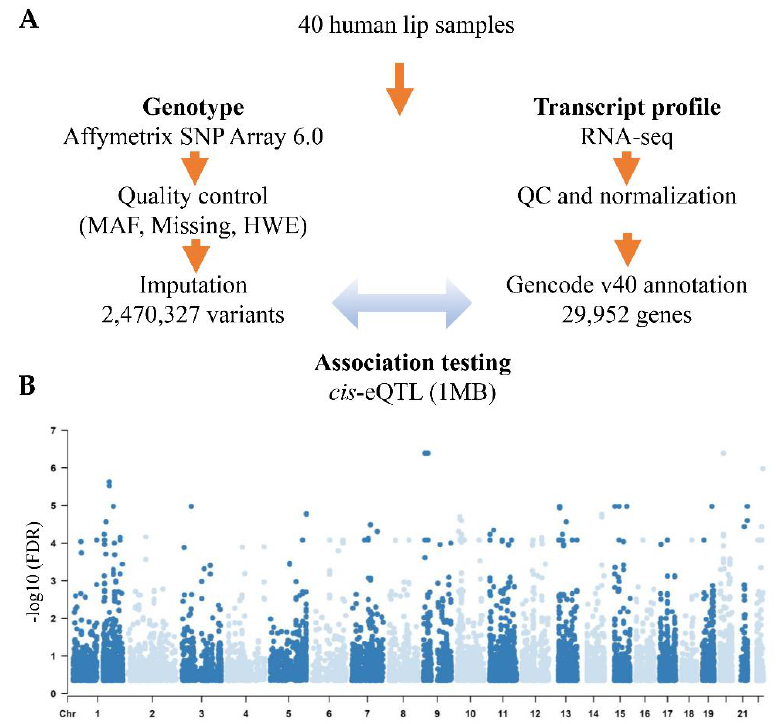
Figure 1. cis-eQTL analysis of lip tissues from NSCL/P patients. ( A ) Flowchart of 40 samples used for eQTL analysis, depicting the steps used to generate the genotype and gene expression data used in the eQTL analysis. ( B ) eQTL SNP-gene pairs across the genome. The x-axis shows the chromosome number, and the y-axis shows the -log 10 (FDR) value.